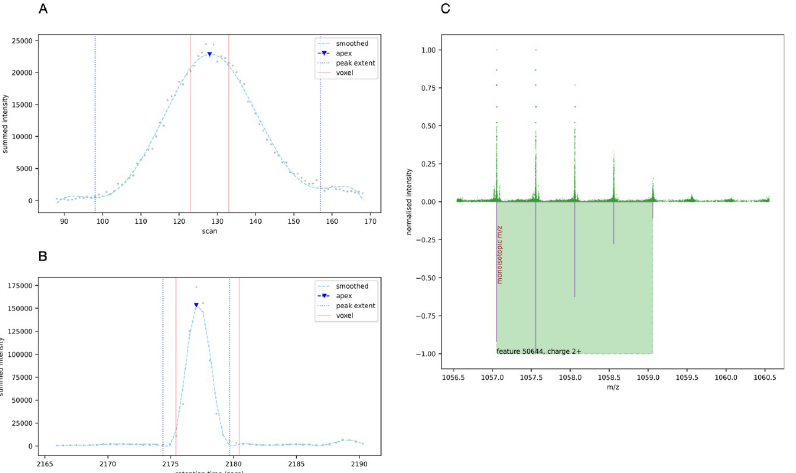
Fig 5. (A) The voxel’s peak flattened to the mobility dimension, with its apex and valleys determining the mobility extent. (B) The same procedure is used for the retention time dimension. (C) The raw points in the 3D feature region flattened to the m/z dimension, and the isotopic peaks proposed for a charge-2